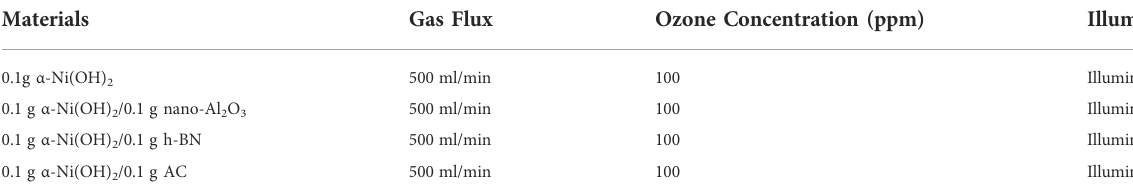
TABLE 3 Effectiveness of α -Ni(OH) 2 and its composites in the degradation of fracturing fl owback liquid.